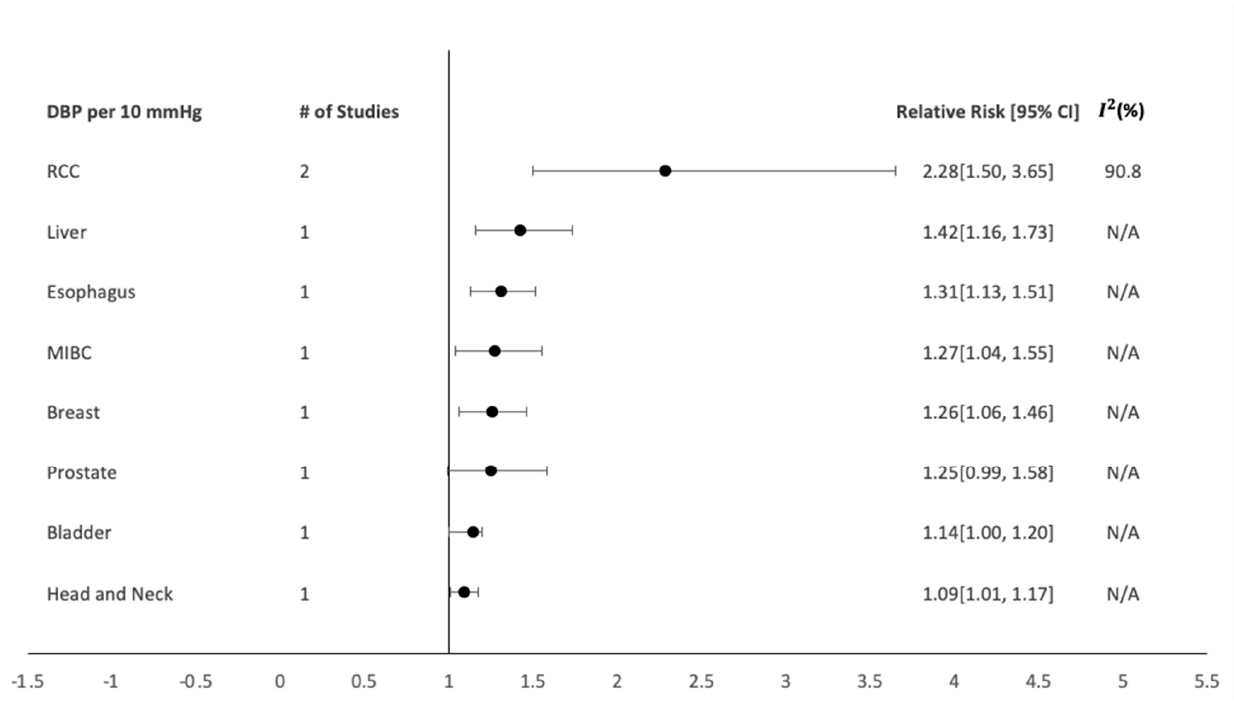
Figure 3. Dose-dependent SBP summary of the relative risks and 95% confidence intervals for each individual organ-specific cancer site.